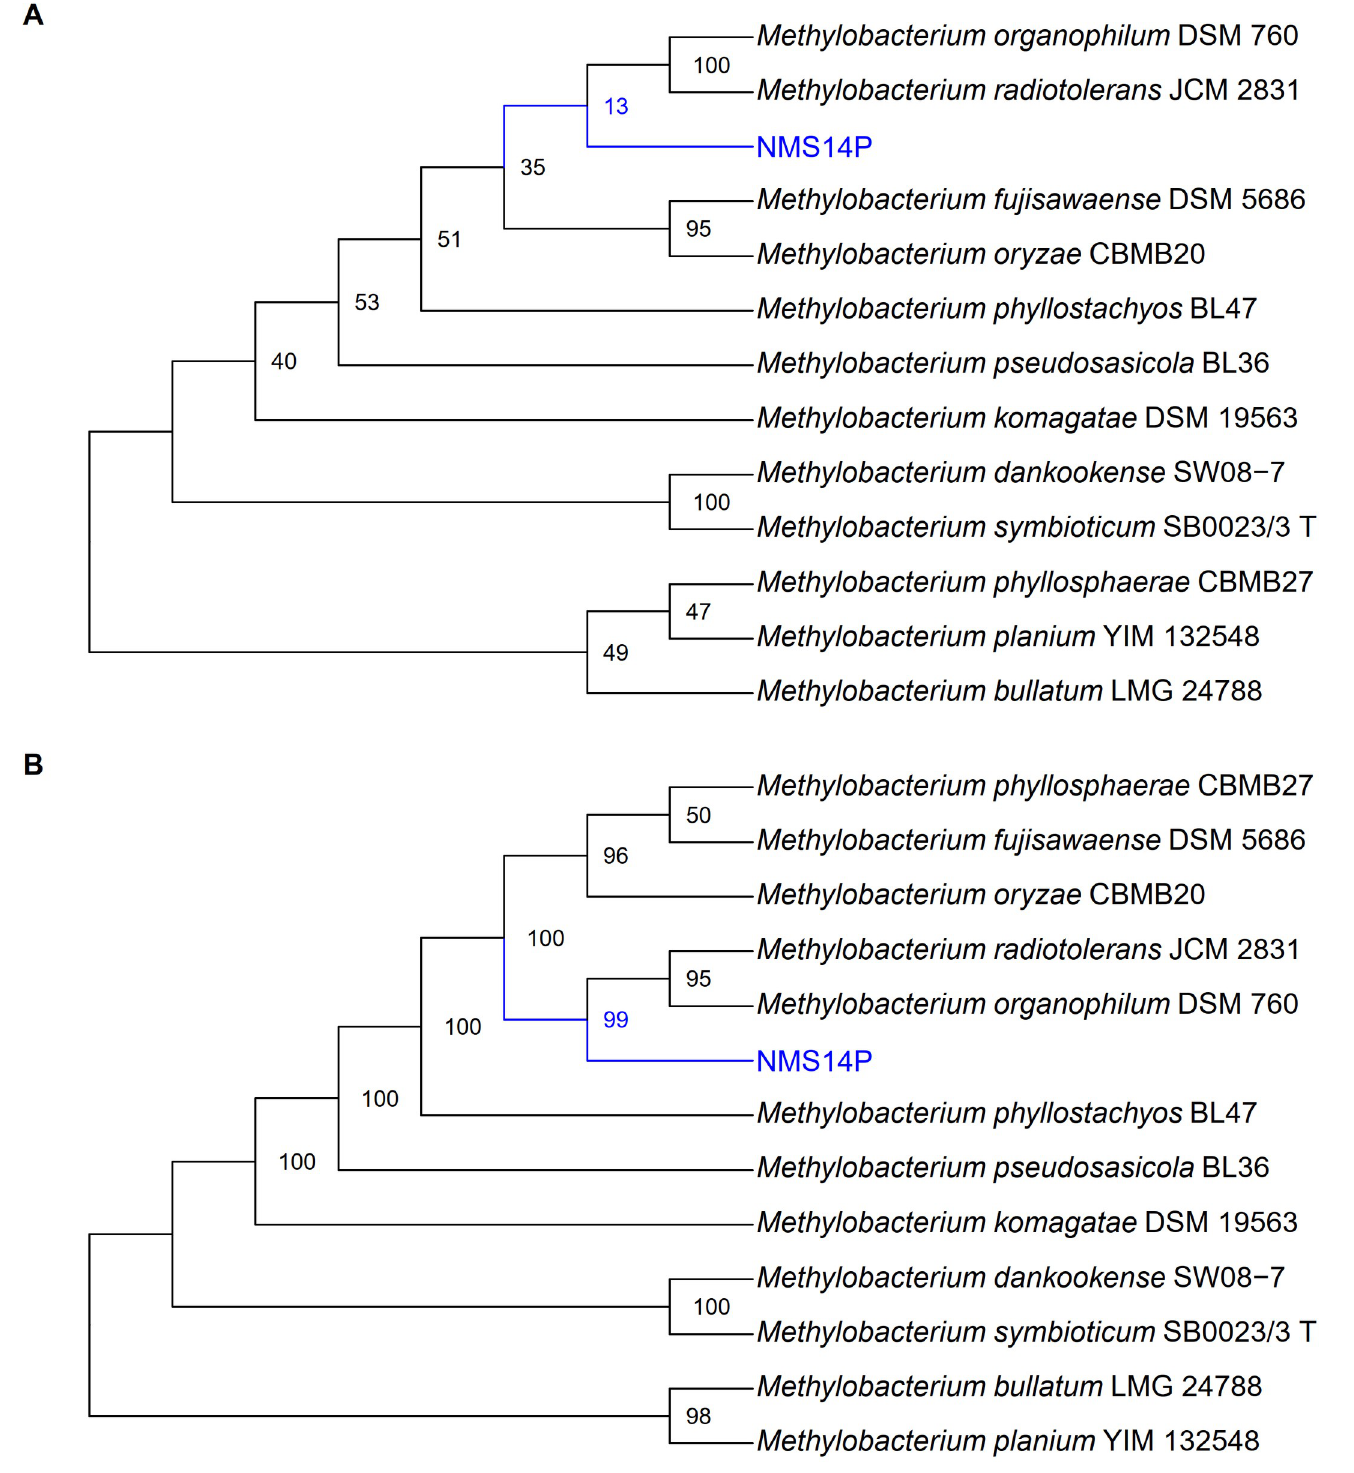
Fig 3. Phylogenetic analysis. Phylogenetic trees of NMS14P and other 11 related species were constructed based on (A) 16S rRNA and (B) whole-genome sequences. The maximum likelihood trees were constructed based on 1,000 bootstrap replications.